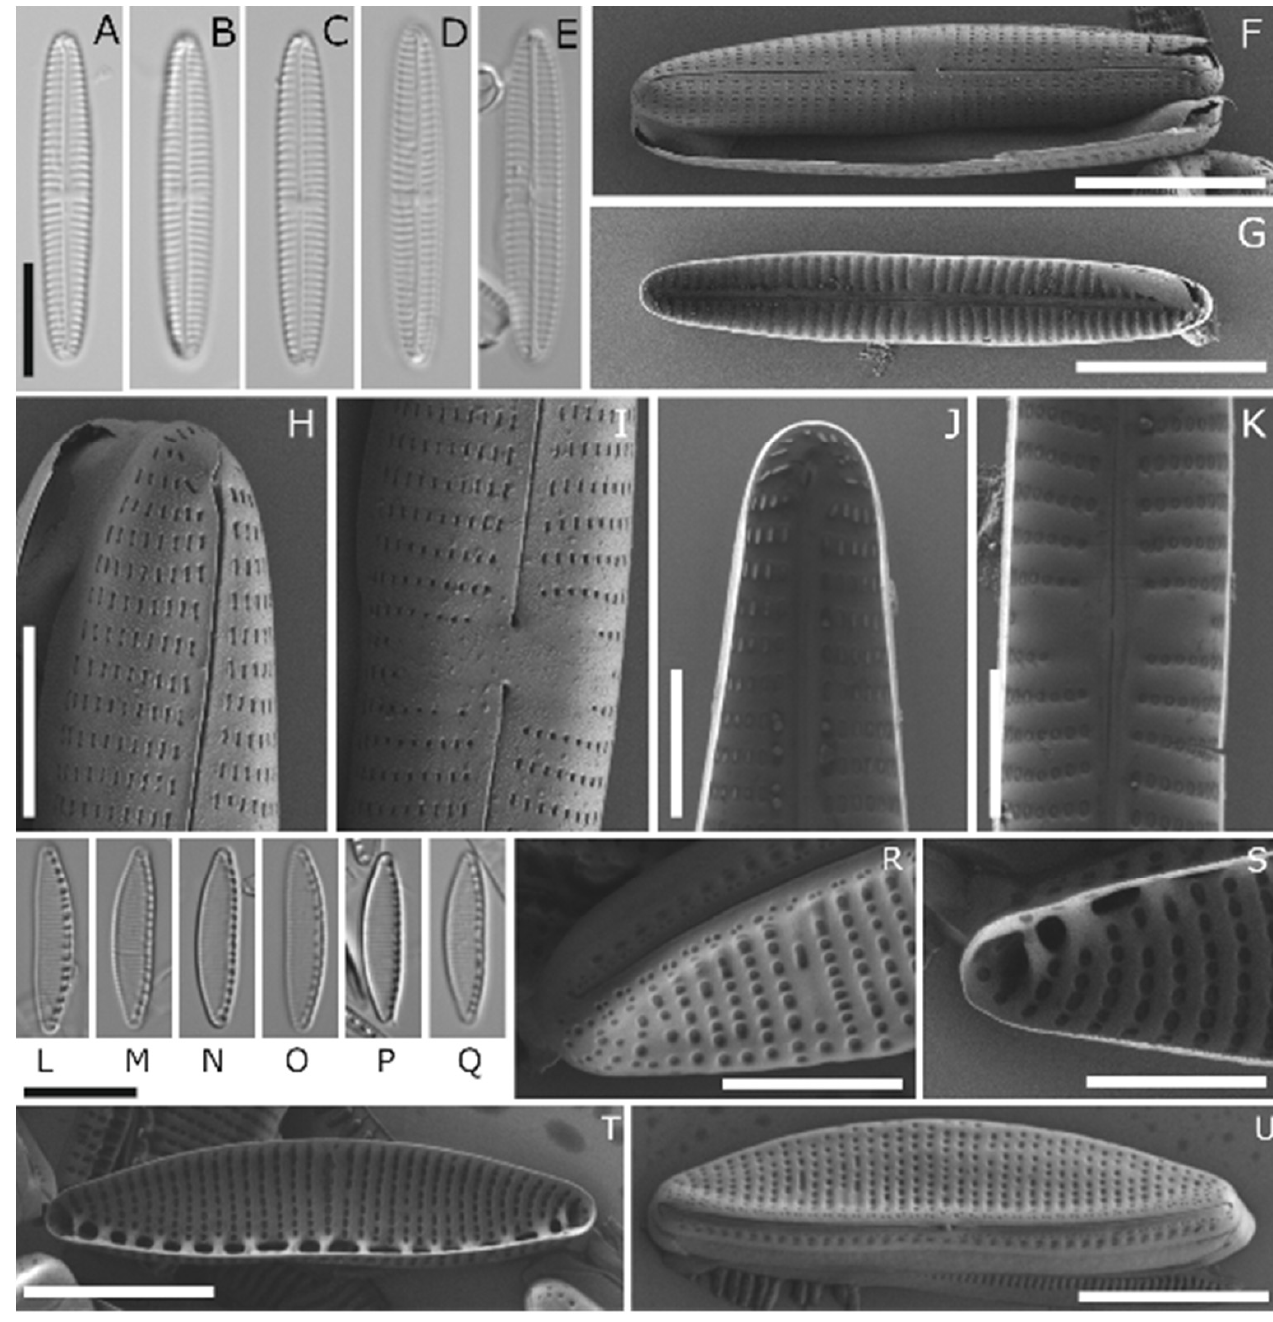
Figure 3. LM and SEM Image Set 2 ( A – U ): ( A – K ) Navicula concordia . ( A – E ) LM pictures. ( F – K ) SEM pictures: ( F ) whole-valve external view, ( G ) whole-valve internal view, ( H ) valve apex external view, ( I ) external proximal raphe endings, ( J ) valve apex internal view, ( K ) internal proximal raphe endings. ( L – U ) Nitzschia annewillemsiana : ( L – Q ) LM pictures. ( R – U ) SEM pictures: ( R ) valve apex external view, ( S ) valve apex internal view, ( T ) whole-valve internal view, ( U ) whole-valve exter- nal view. Scale bars: ( A – G ) and ( L – Q ) 10 µm, ( H – K ) and ( R , S ) 3 µm, and ( T , U ) 5 µm.